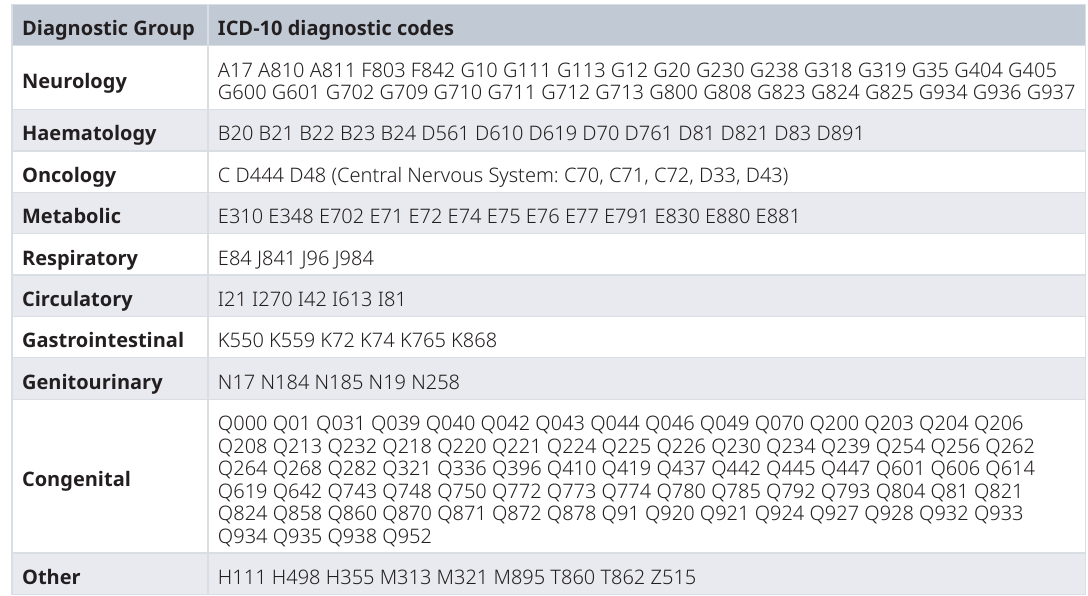
Table 1. Coding framework for life-limiting conditions. Diagnostic Group ICD-10 diagnostic